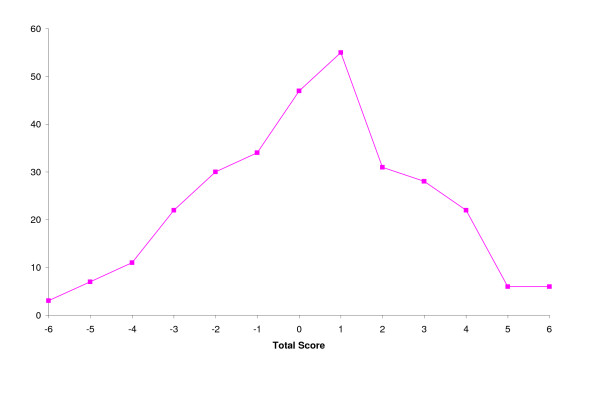
Distribution of 'holistic' quality scores across PCTs.